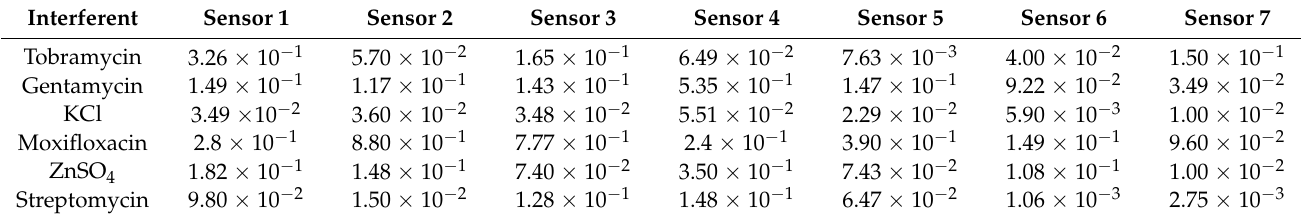
Table 3. Potentiometric selectivity coefficients (K pot Gemi, interferent ) * for the investigated gemifloxacin screen-printed sensors.